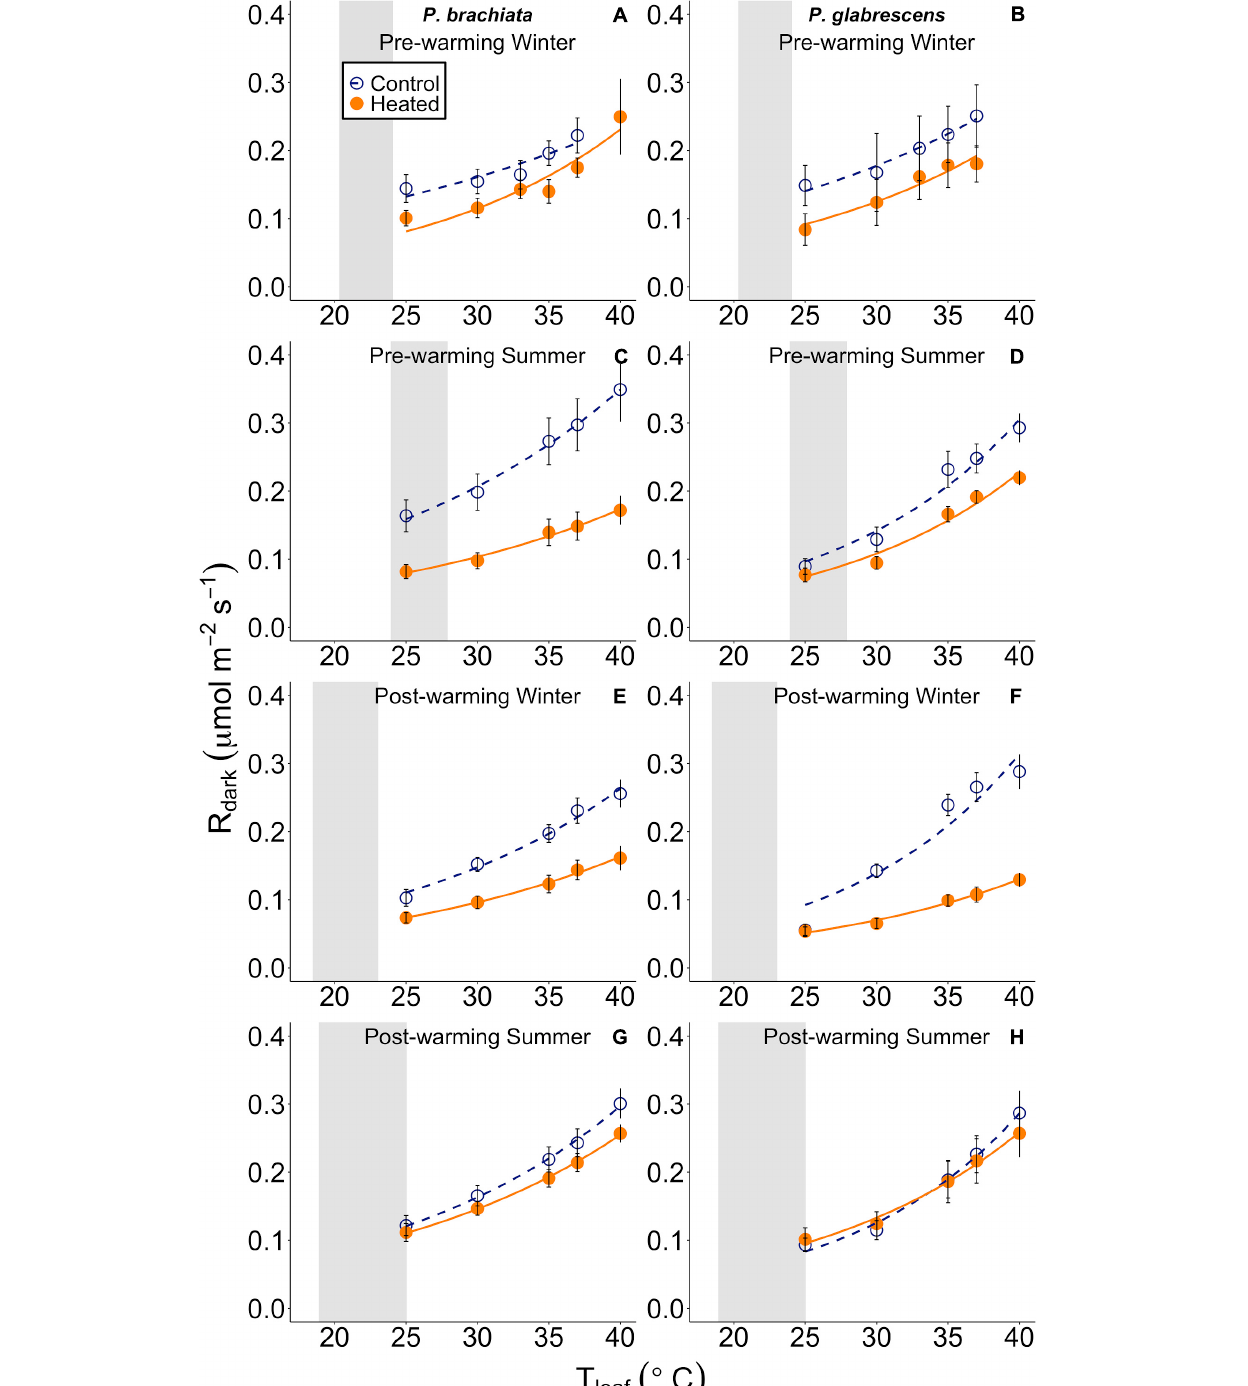
Frontiers in Forests and Global Change |